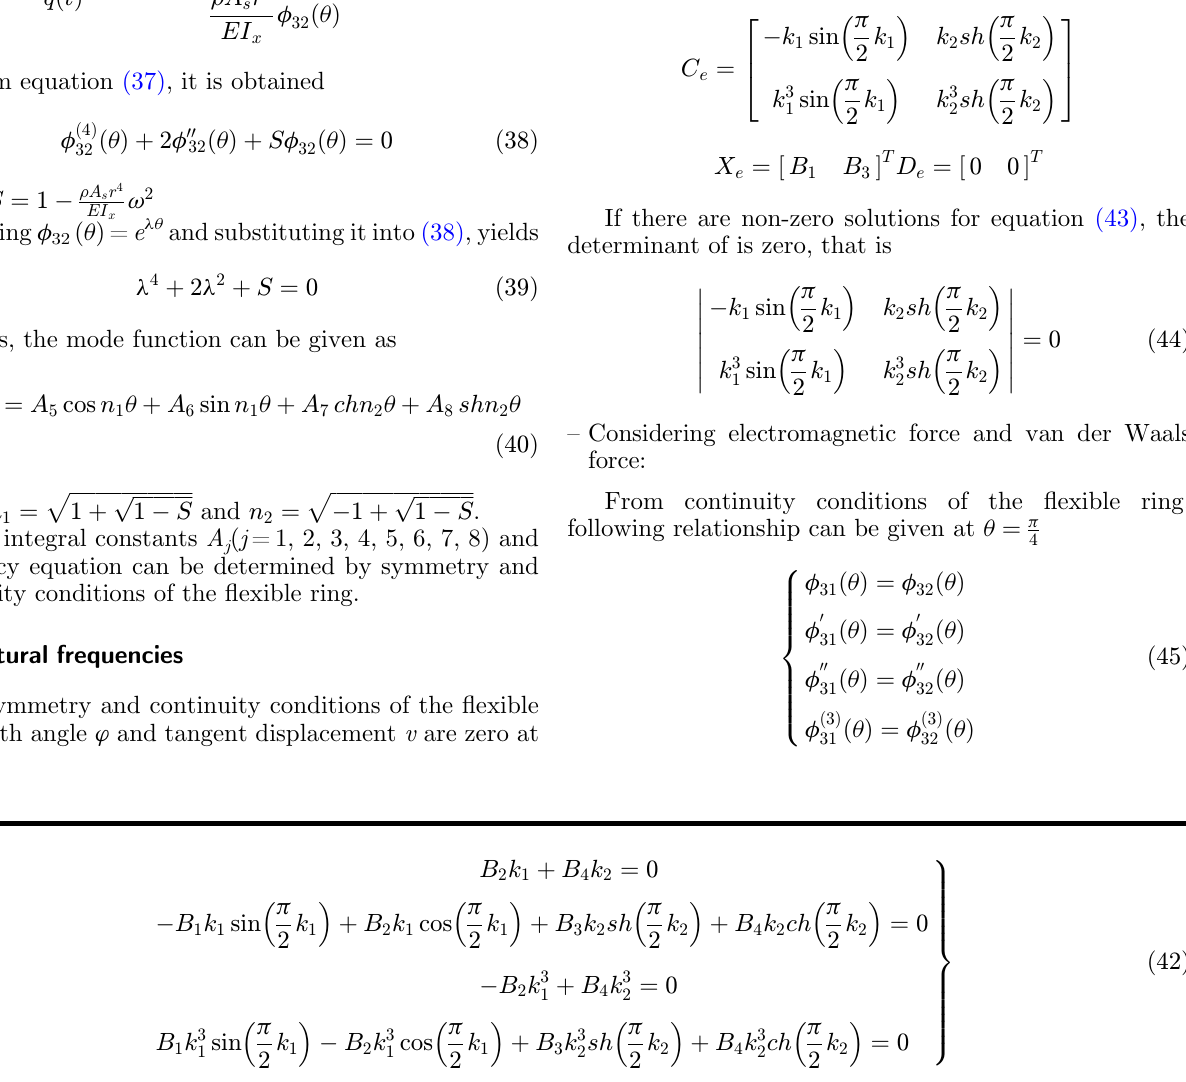
ffiffiffiffiffiffiffiffiffiffiffiffiffiffiffiffiffiffiffiffiffiffiffiffiffi ffiffiffiffiffiffiffiffiffiffiffiffi p p 1 þ 1 (cid:1) R